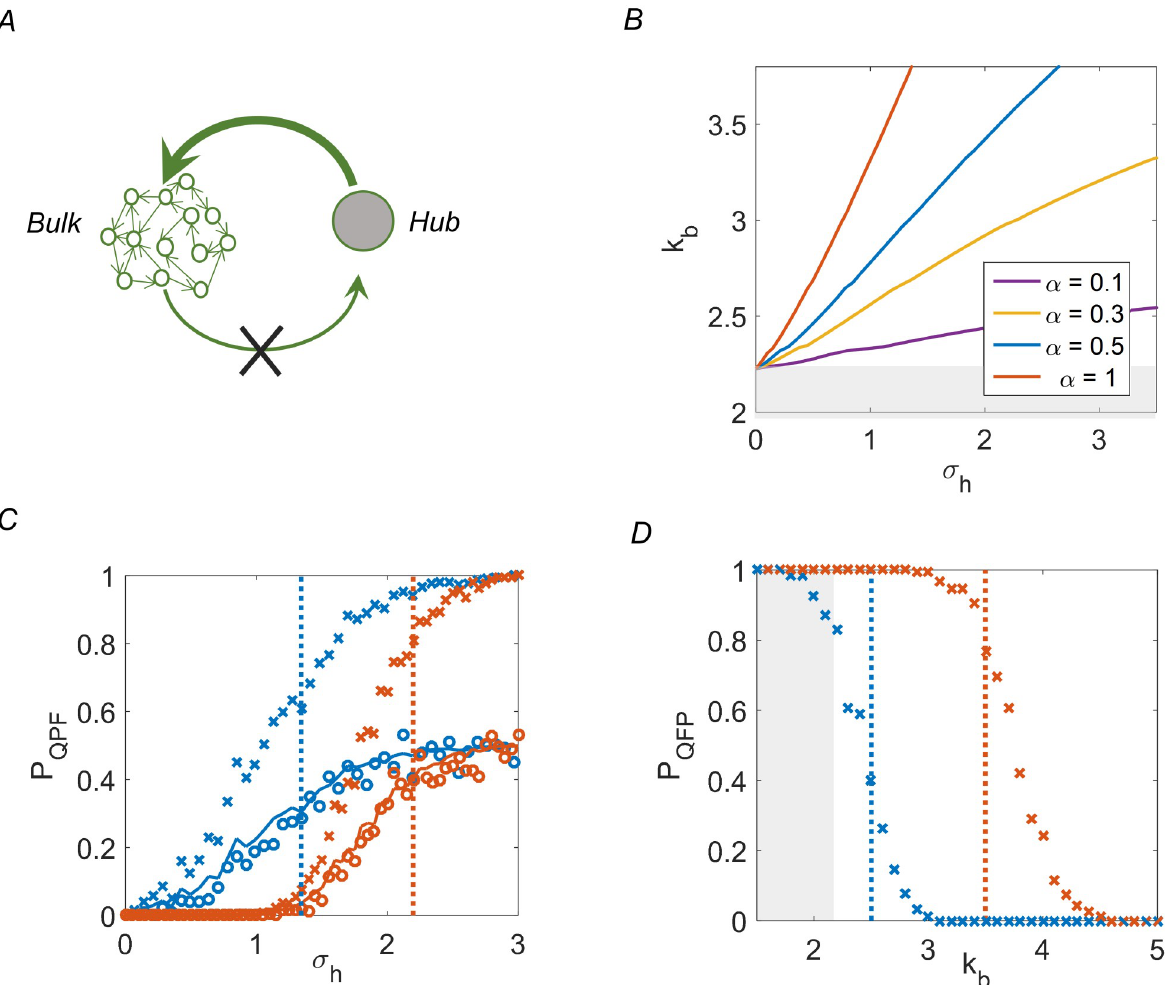
Fig 5. Feedback analysis for the lumped-hub network ensemble. (A) Conceptual scheme of feedback analysis. The lumped-hub network contains a single hub (gray) connected to a homogeneous network representing the bulk (green). In the open loop setting, the hub is clamped to a fixed value while its incoming connections from the bulk are disabled ( × ). (B) Mean Field Theory predicts a threshold value of σ h above which chaos in the bulk network is suppressed and the system is driven to a stable fixed point. These transition lines are plotted in the ( k sparseness α . (C) The Probability of converging to a QFP for lumped-hub network ensembles computed as a function of hub strength σ h , for open- loop (crossmarks, converging to 1) and closed-loop (circles, converging to 1/2). Two values of average bulk connectivity and sparseness are shown: k b = 3, α = 0.5 (blue) and k b = 5, α = 1 (red). MFT-predicted transition is depicted by vertical lines of the corresponding color. The solid lines are the open loop values divided by two. The numerical results confirm both the transition point and the factor of half due to closing the loop. N = 1500, and statistics is obtained from 239 realizations. (D) Same as (C), for the open loop case and as a function of k b for fixed ( σ h , α ) with N = 5000. Blue: ( σ h = 1.0, α = 0.25), red: ( σ h = 2.12, α = 0.5). Statistics is obtained from 180 realizations. Gray regions in (B) , (D) denote the limit of validity of MFT (See section Limits to the lumped hub approximation